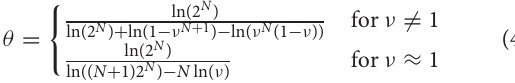
FIGURE 4 | vessels labeled according CG method. (D) Same network as in (C) , now color coded by difference vessels defined according to HS labeling. (E) Histogram of length-scale factors calculated using CG labeling (red) or HS labeling (blue). Importantly, metabolic scaling theory predicts that vessel lengths branch according to l D j − 1 = l D j , µ + l D j , ν , where D represents the fractal dimension and should be equivalent to the Euclidean dimension of the space being filled. Estimates of the fractal dimension using HS labeling fall within the expected range of D ∈ [2,3], compared to the non-intuitive value of D = − 2.47 for CG